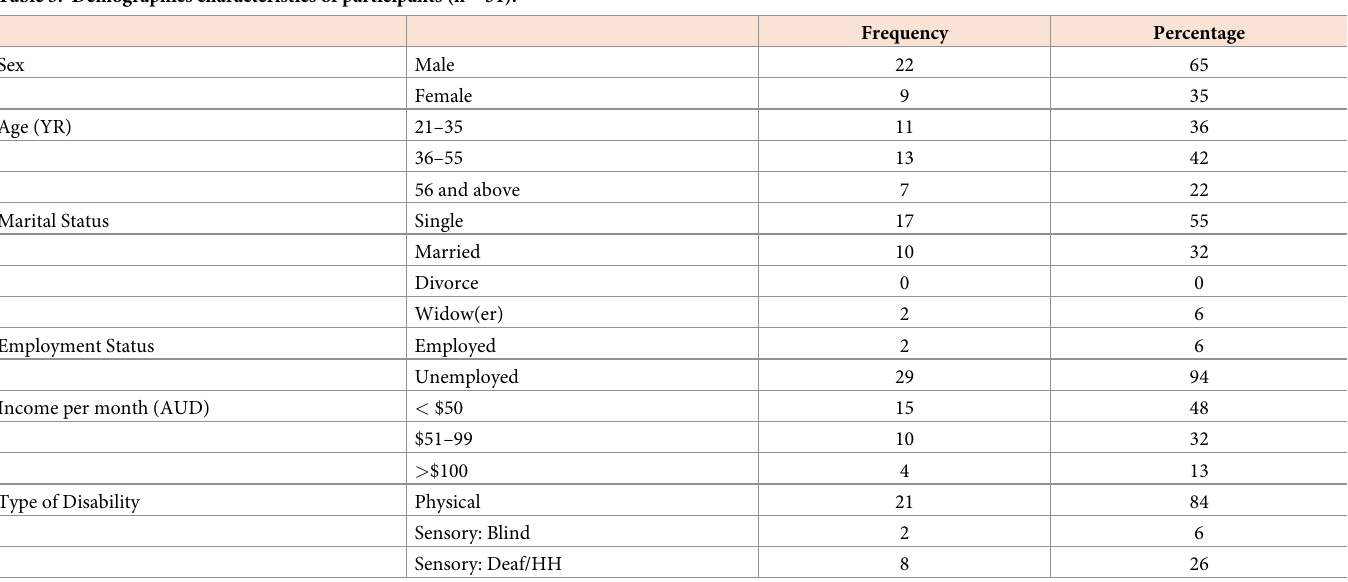
Table 3. Demographics characteristics of participants (n = 31).